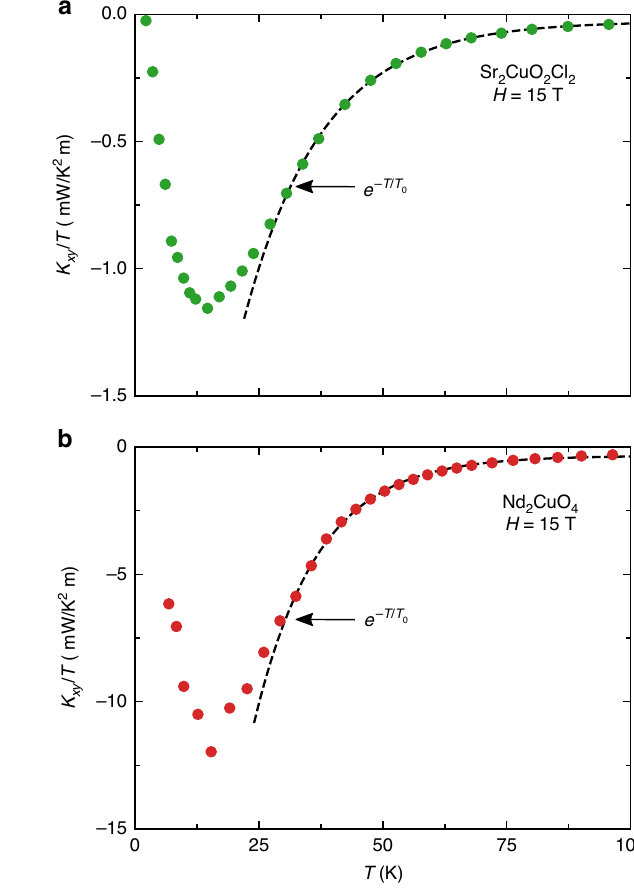
Fig. 6 Phenomenological fi t to the phonon thermal Hall conductivity. Thermal Hall conductivity, plotted as κ xy / T vs T in a Sr 2 CuO 2 Cl 2 (sample A) and b Nd 2 CuO 4 . The data are fi t to the phenomenological expression κ xy / T = A exp( − T / T + C from ref. 29 . The fi t interval is 30 – 100 K. The resulting 0 ) fi t parameters are a A = − 5 mW/K 2 m, C = − 0.03 mW/K 2 m, T